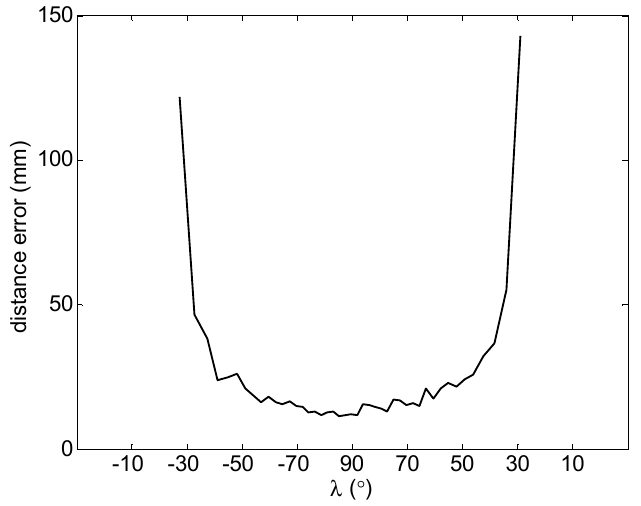
Figure 7. Maximum error in individual distance measurement relative to the angle of incidence λ